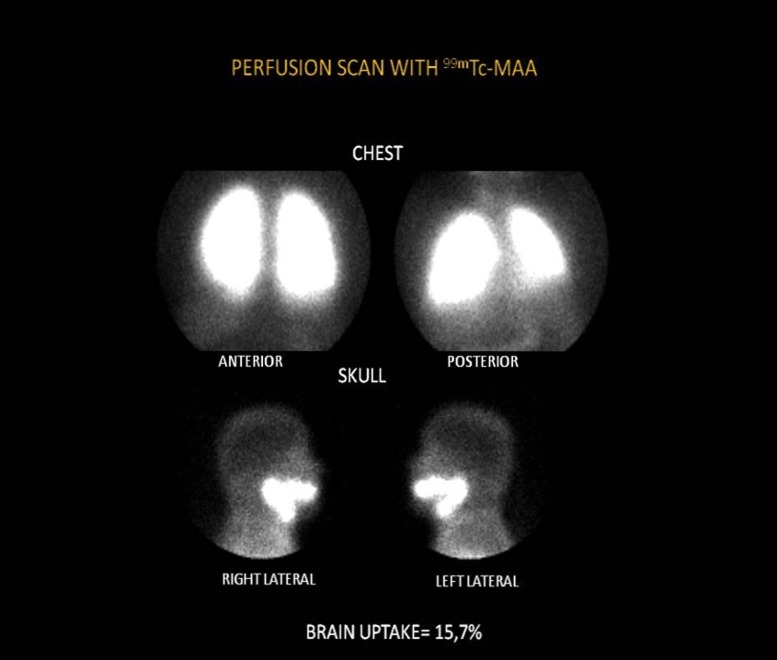
Anormal scintigraphy.Brain uptake = 15.7%.